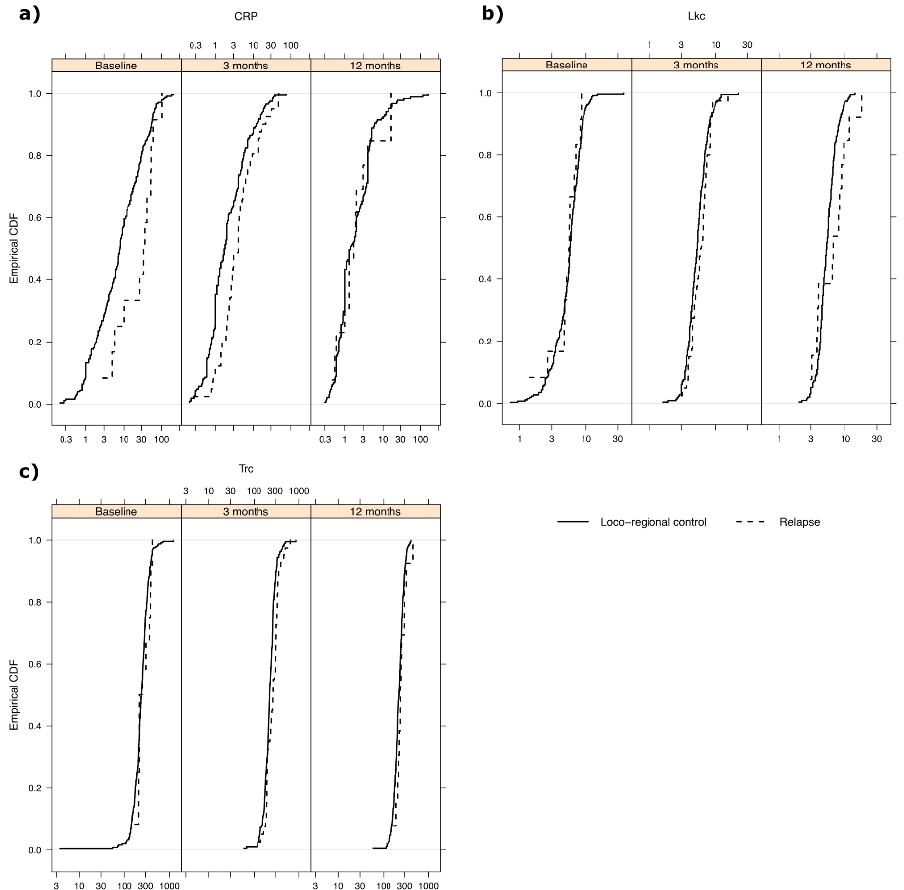
Figure 2. Empirical cumulative distribution functions for the three examined prognostic blood markers. ( a ) CRP was elevated in the recurrence group, defined as recurrence occurring before the next follow-up. CRP elevation in this group was evident at pre-treatment and at 7 weeks and 3 months after the start of treatment. ( b ) Lkc counts did not differ between recurrence and loco- regional control groups at any time point. ( c ) Trc counts did not differ between recurrence and loco-regional control groups at any time point.